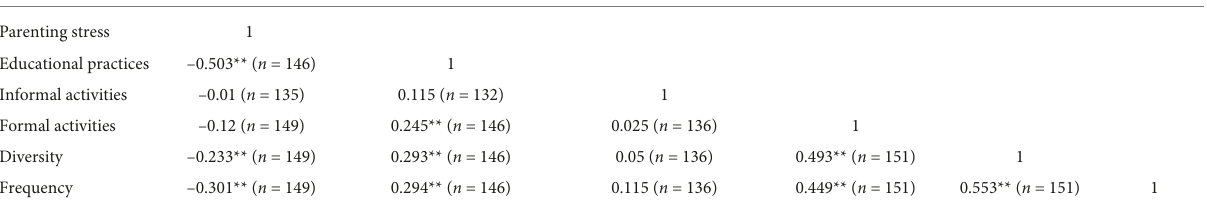
TABLE 1 Correlation between independent